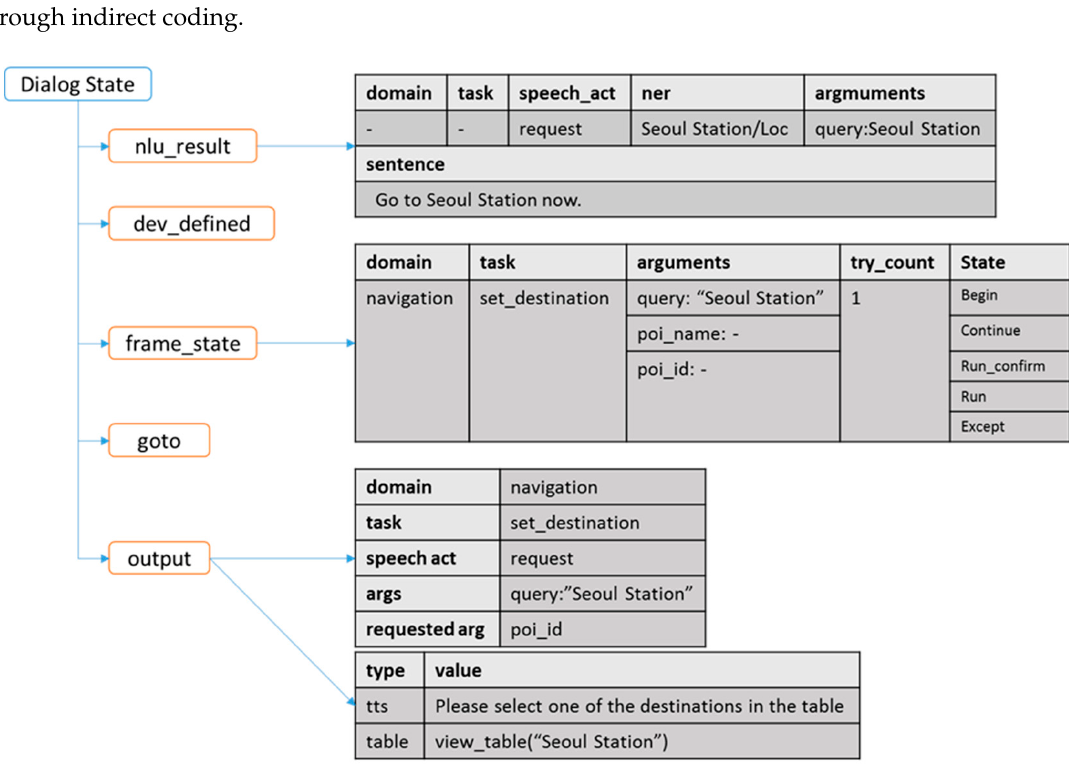
Figure 3. External modules and module router.